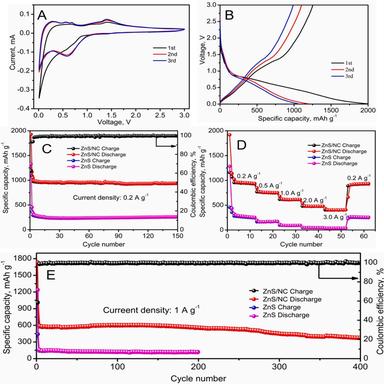
Electrochemical performance in LIBs: (A) CV curves from 0.01 to 3 V at a scan rate of 0.1 mV s−1 and (B) Discharge/charge profiles for initial three cycles; (C) Cycling, (D) Rate and (E) Long-term cycling performance of ZnS/NC composite and ZnS at 1.0 A g−1.